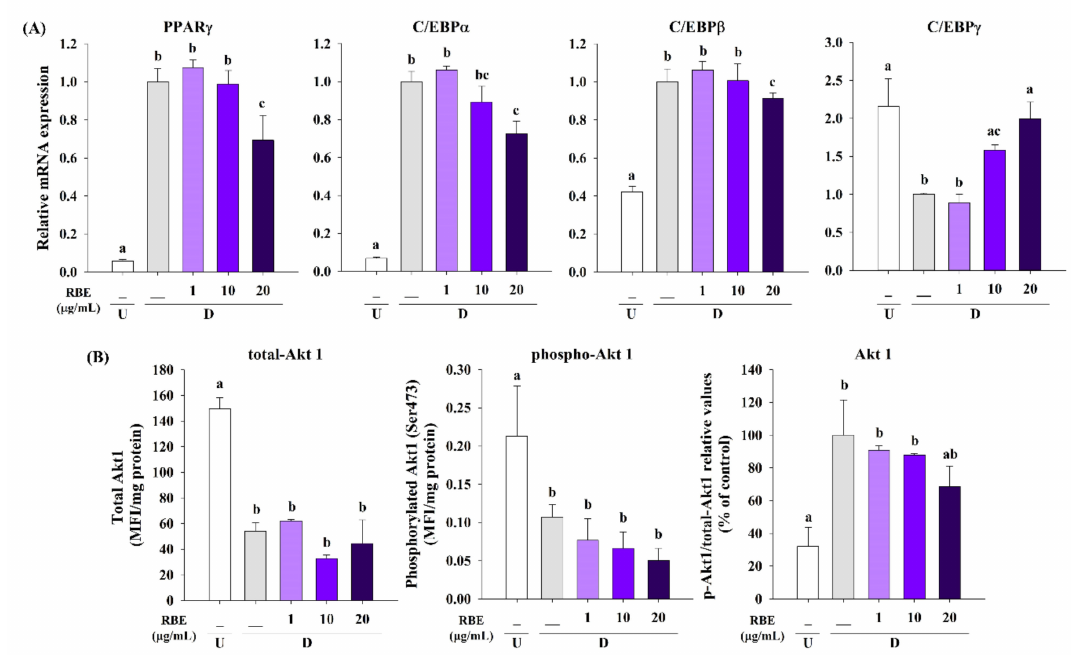
Figure 5. E ff ect of Riceberry rice extract (RBE) on adipogenic transcription factors and Akt1 signaling in 3T3-L1 cells. ( A ) RBE (20 µ g / mL) significantly downregulated mRNA expression of PPAR γ , C / EBP α , and C / EBP β , and upregulated C / EBP γ in di ff erentiated cells. ( B ) Treatment of cells with RBE tended to reduce the relative values of phospho-Akt1 (S473) to total-Akt1 in di ff erentiated cells. The results are expressed as mean ± SEM from the three independent experiments. Groups with a di ff erent letter represent statistical significance ( p < 0.05). Data were normalized with β -actin as an internal control. U: undi ff erentiated cells; D: di ff erentiated